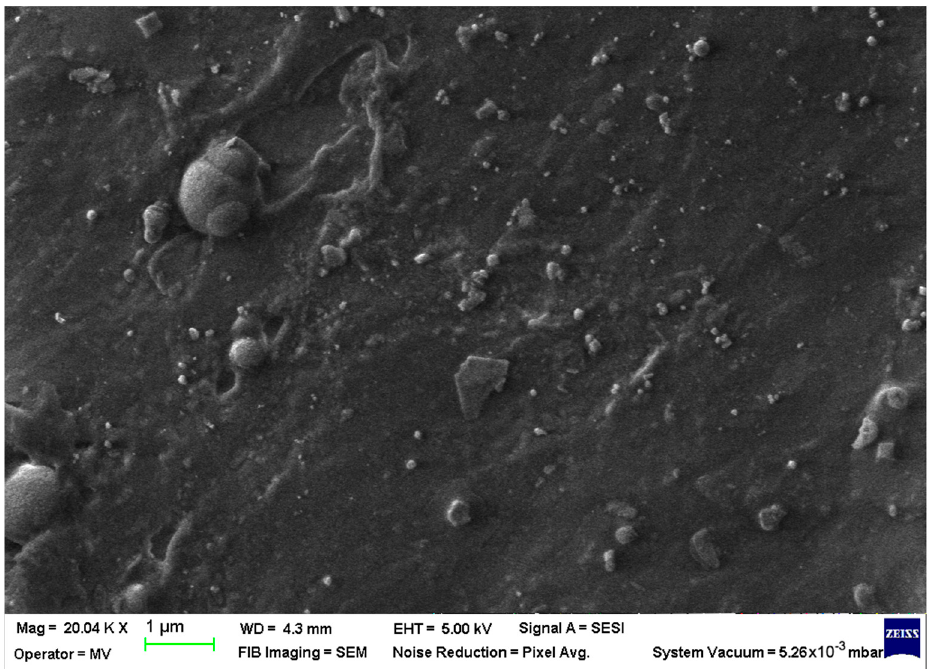
Figure 13. SEM micrographs of PET–HDPE–Al composite (M13) sample at T 0 (1 μ m scale). The HDPE and PET smooth pattern surface of samples M14 (Figure 14) and M15 (Figure 15) is disordered by the Fe nano-powder content, showing different lumps, more pronounced at a higher concentration.